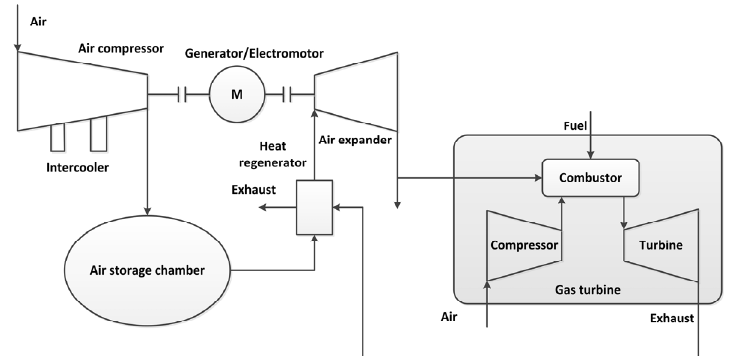
Figure 3. Schematic of the second-generation CAES power system.